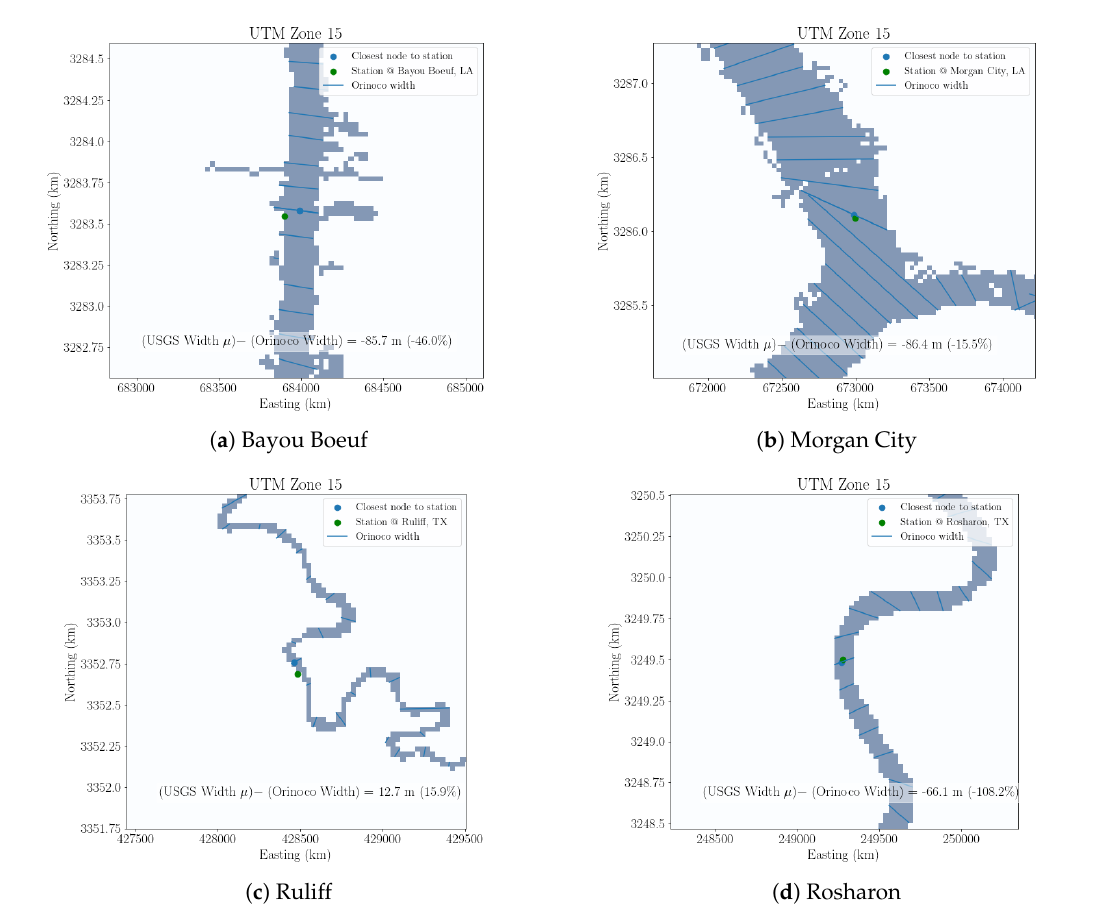
Figure 10. The USGS stations and closest Orinoco node along with the measured width. In the background is the GRWL water mask. The error is Orinoco width subtracted from the mean USGS measurement. The percent error is this error as a percent relative to the mean USGS